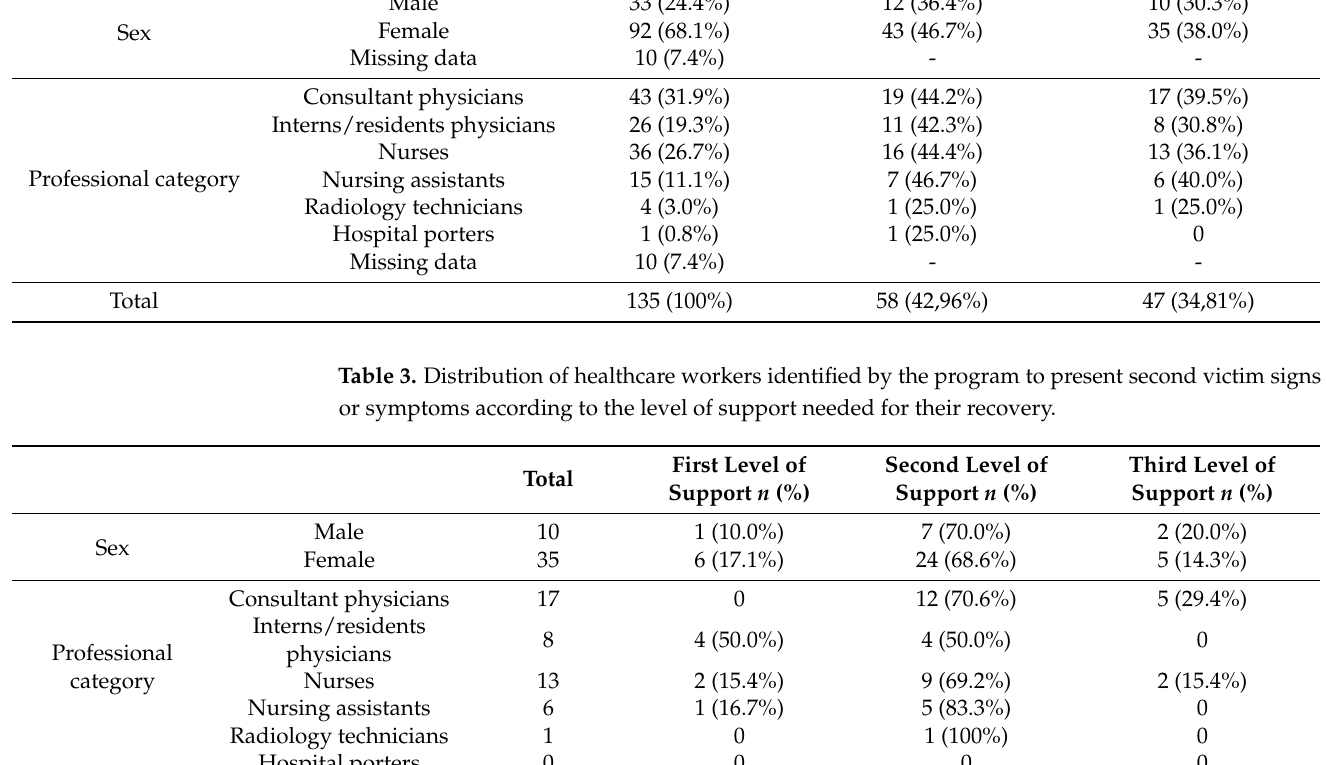
Table 2. Distribution by sex and professional category of the healthcare workers interviewed accord- ing to the self-reported first level of support received and those identified by the program as “second victims”. Self-Reported First Level Health Workers Interviewed n (%)